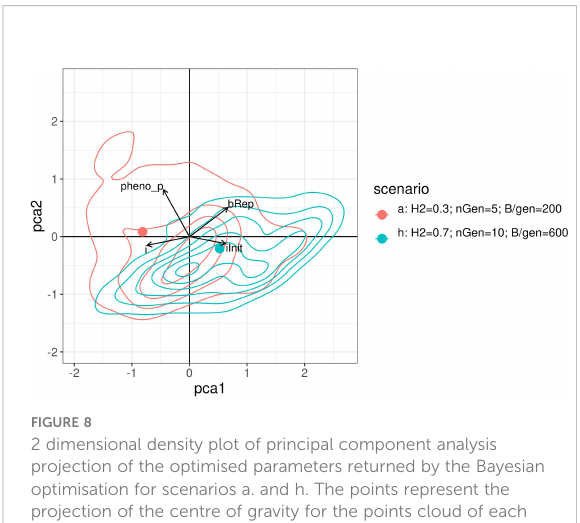
FIGURE 8 2 dimensional density plot of principal component analysis projection of the optimised parameters returned by the Bayesian optimisation for scenarios a. and h. The points represent the projection of the centre of gravity for the points cloud of each